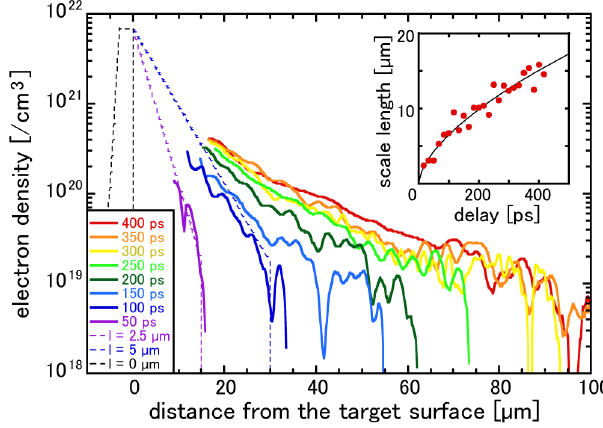
FIG. 4. Evolution of electron density distribution (solid lines). The inset shows an expansion of the scale length versus time obtained by fitting the electron density distribution for various time delays. Dashed lines show the electron density distributions with scale lengths of 0, 2.5, and 5 μ m used for the 2D PIC